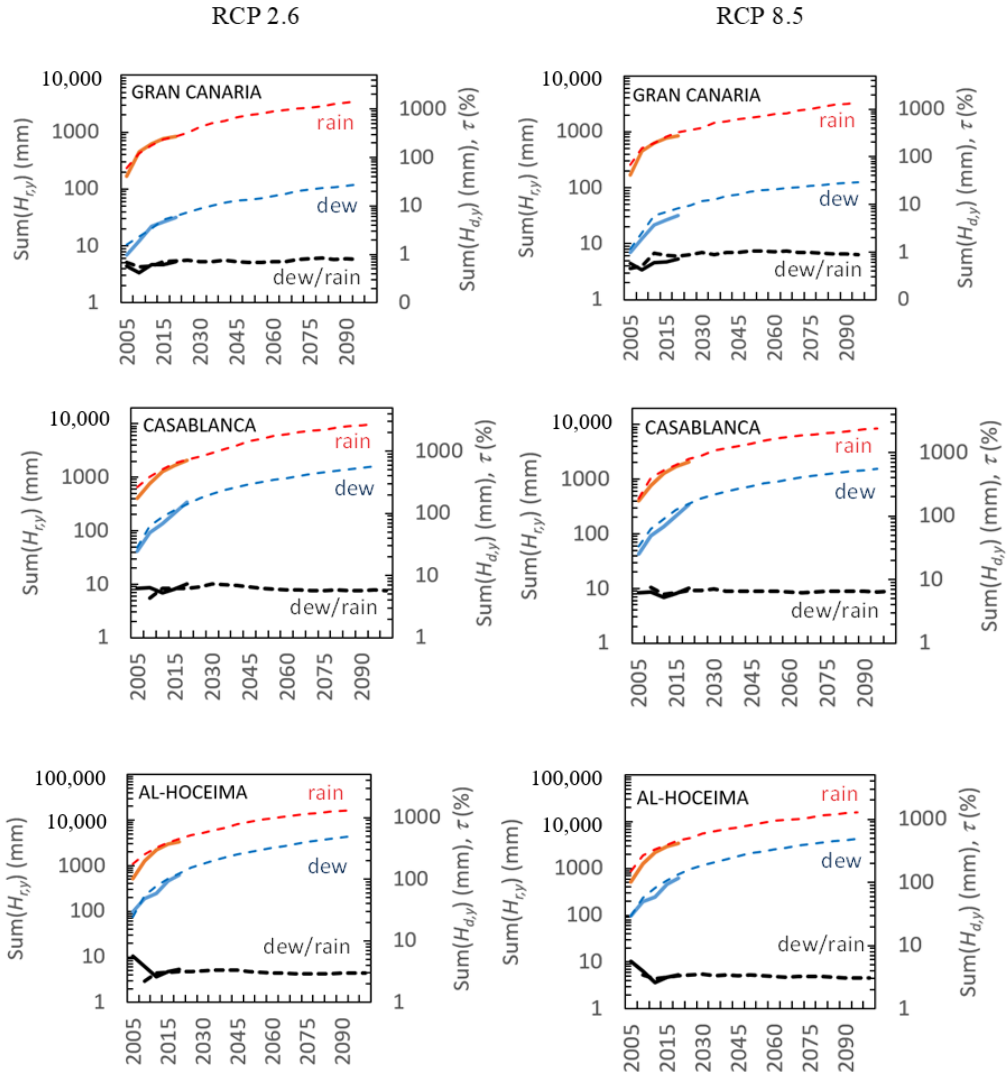
Figure 9. Semi-log plot for Gran Canaria, Casablanca and Al-Hoceima of the yearly summed values of dew ( H d,y , blue, mm · yr − 1 , right axis), rain ( H r,y , red, mm · yr − 1 , left axis), and their ratio τ = sum( H d,y )/sum( H r,y ) (black, dimensionless, right axis). The full curves correspond to the measured values (2005–2020), and the interrupted curves to predicted values (2006–2100) according to scenar- ios RCP 2.6 ( left ) and RCP 8.5 ( right ).